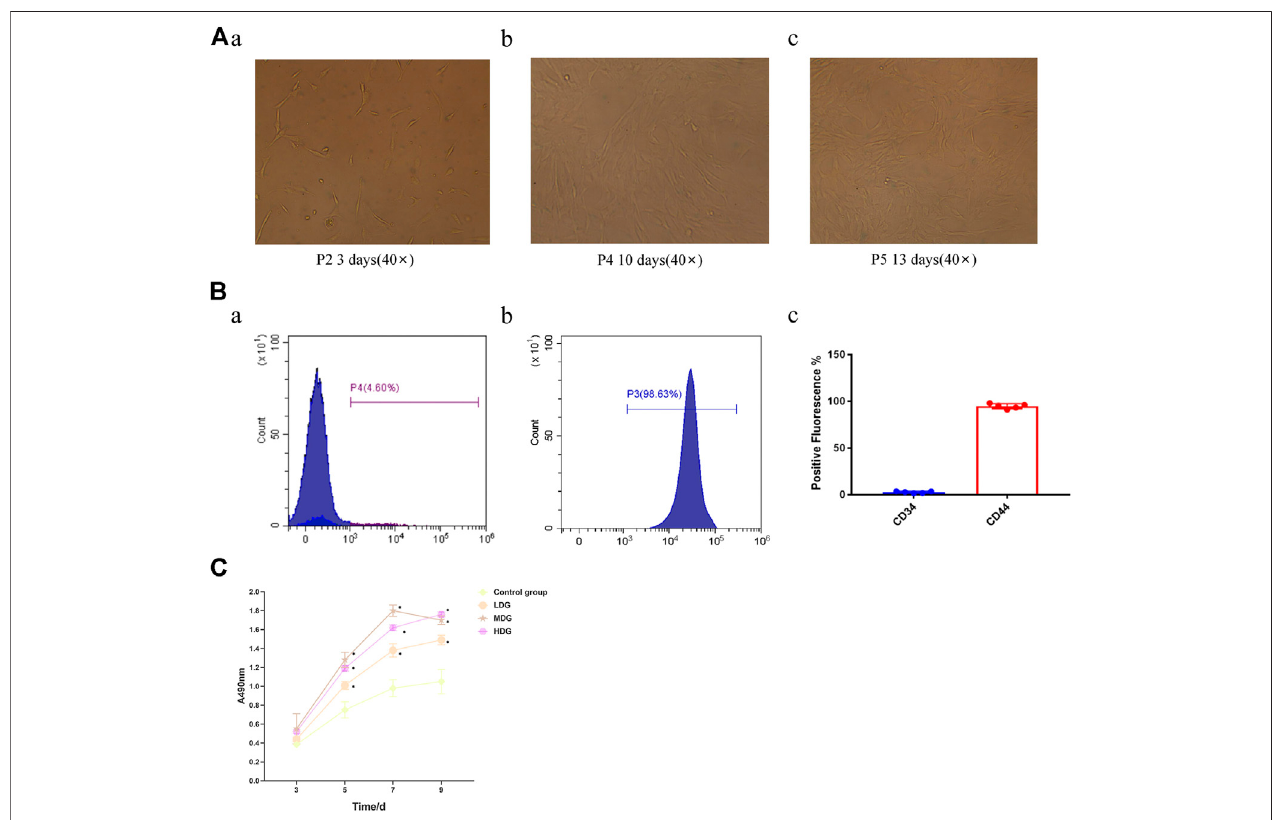
FIGURE 6 | Identi fi cationandcellviabilityassayofBMSCs (A) photomicrographofBMSCsmorphologyfromSprague-Dawleyrats(40 × )(a)TheBMSCsmorphologywas extended to fusiform or polygonal after incubation for 3 days; (b) The BMSCs morphology was merged with each other after incubation for 10 days (c) The BMSCs morphology was stretched out like a uniform shape of spindle by degrees after incubation for 13 days. (B) Surface marker expression of BMSCs (a)The expression of surface marker CD44 indicated negative results; (b) The expression of surface marker CD34 showed negative results; (c) Quanti fi cation of surface marker expression of BMSCs. (C) The CCK-8 assay of BMSCs exposed to 3, 5, 7, and 9 days (* p ＜ 0.05 vs. control group). The data are expressed as the mean ± SEM of three independent experiments.